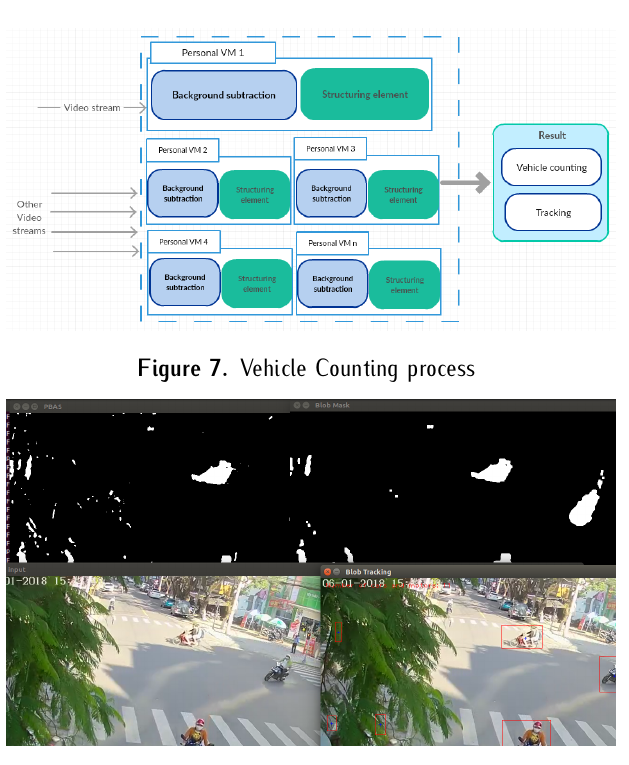
Figure 8. Vehicle Counting